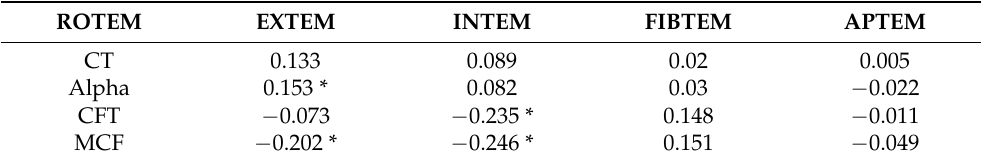
Table 2. Linear correlation of clot lysis index obtained with four ROTEM™ tests (EXTEM, INTEM, FIBTEM, APTEM) with the ROTEM™ variables CT, alpha angle, CFT, and MCF. Asterisks indicate significant correlations ( p <